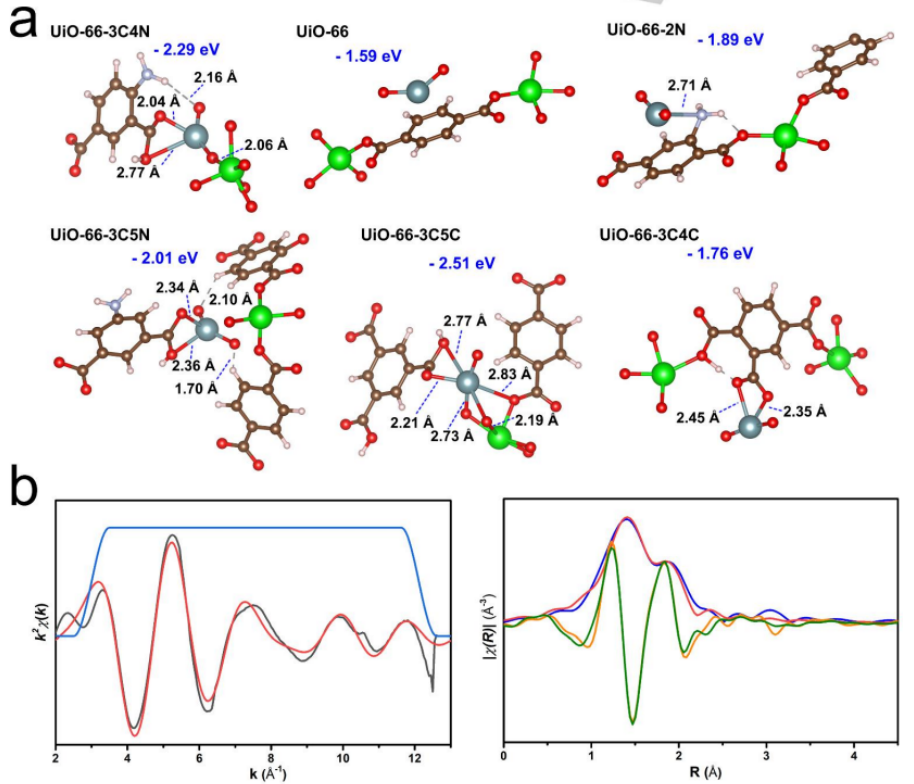
Figure 1. Structure of USC-CP-1 (the purple, yellow and green units represent three different mi- cropores), ( a ) molecule used for synthesis of USC-CP-1, ( b ) SEM of USC-CP-1 , ( c ) equilibrium data with continuous line fit based on the Langmuir model of uranyl adsorption on USC-CP-1 at pH 5.5 [31], Copyright 2019 John Wiley and Sons.